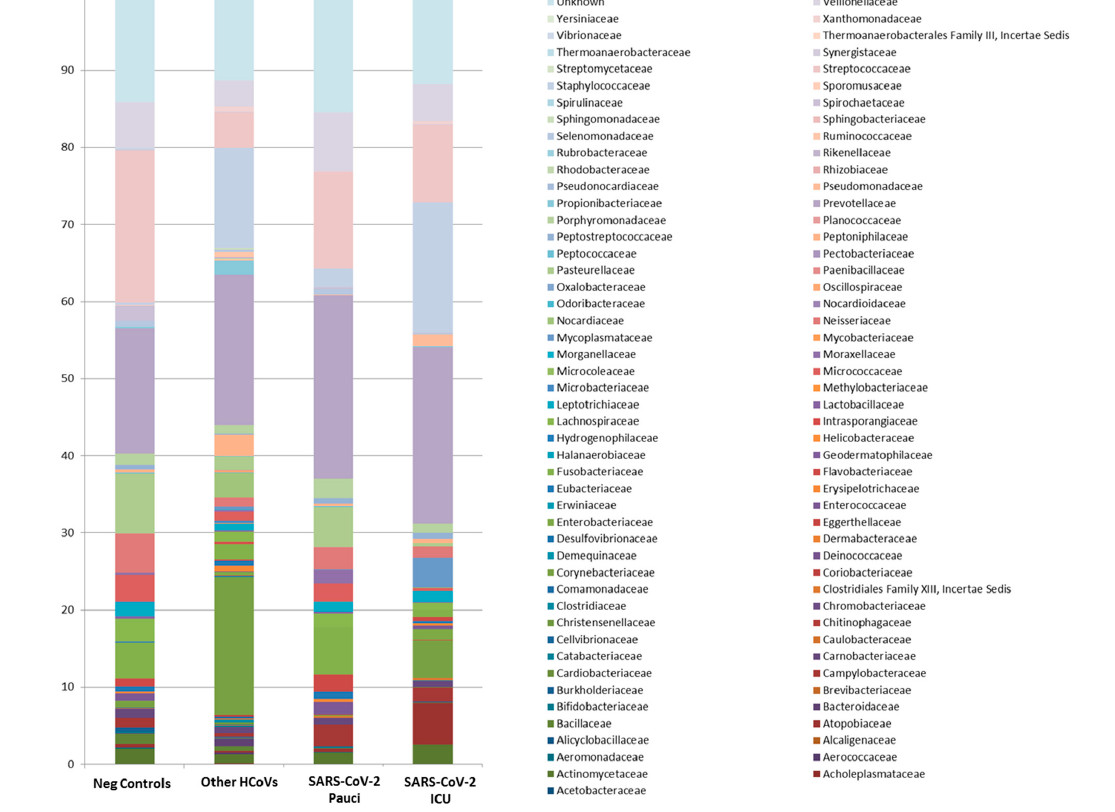
Figure 3. Microbiota composition of Neg Controls, Other HCoVs, SARS-CoV-2 Pauci and SARS-CoV-2 ICU at the family level. The mean value of all the detected taxa is represented. At the lower taxonomic level, Johnsonella, Tepidiphilus, Thermoanaerobacter, Ther- moanaerobacterium, Thermosinus and Variovorax were exclusive to Neg Control pa- tients, while Salmonella, Scardovia, Serratia and unk_Pseudomonadaceae were included exclusively in SARS-CoV-2 ICU patients (Figure 4 and Supplementary Table S1).